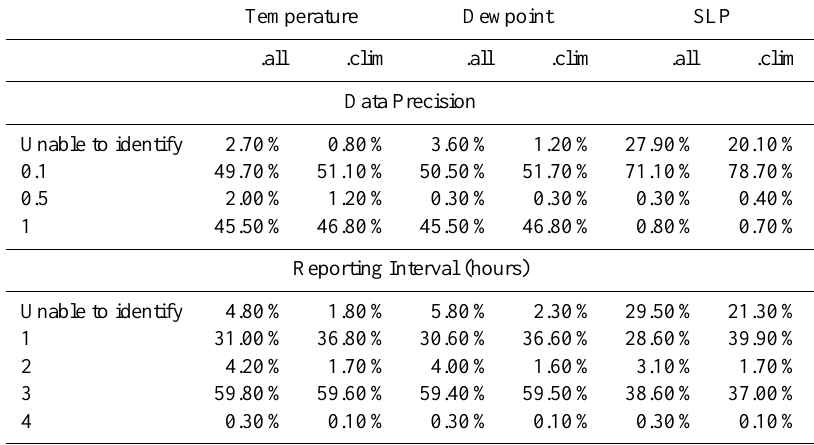
Table 7. Data precision and reporting interval by month for all of the 6103 stations ( .all ) and the 3427 filtered stations ( .clim ). Months with no data at all are not counted, but those with few data are unlikely to have well-determined accuracies or reporting intervals and will fall under the unable-to-identify category.